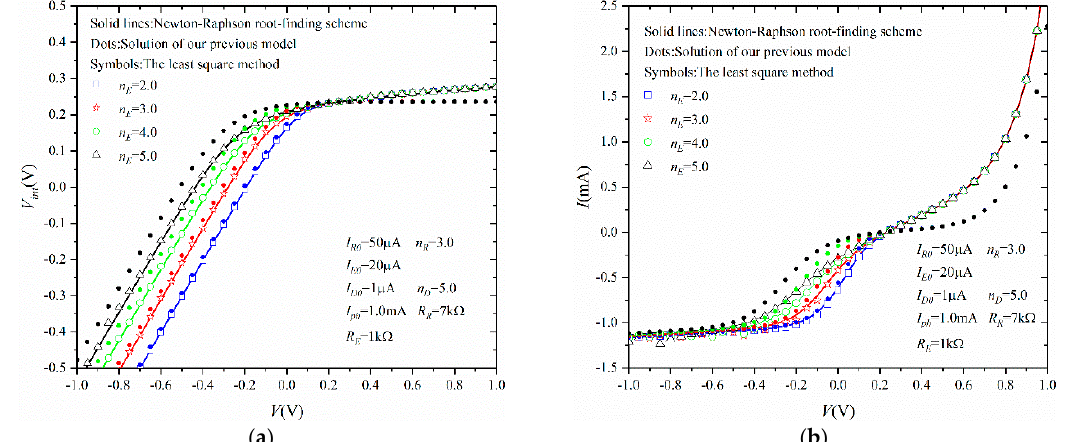
Figure 9. ( a ) V int ( V ) and ( b ) I ( V ) of the circuit in Figure 2 for different n E .